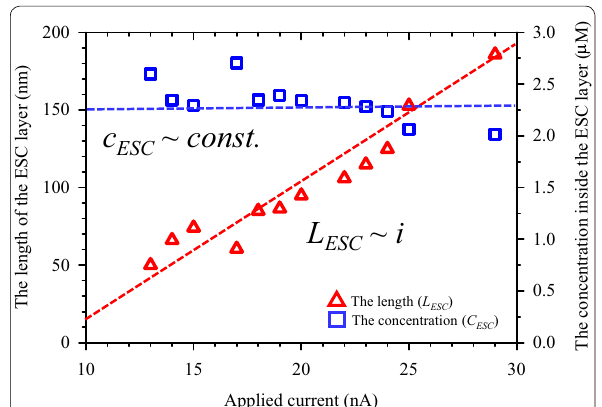
Fig. 5 The length ( L ESC ) and the concentration ( c ESC ) of the ESC layer,